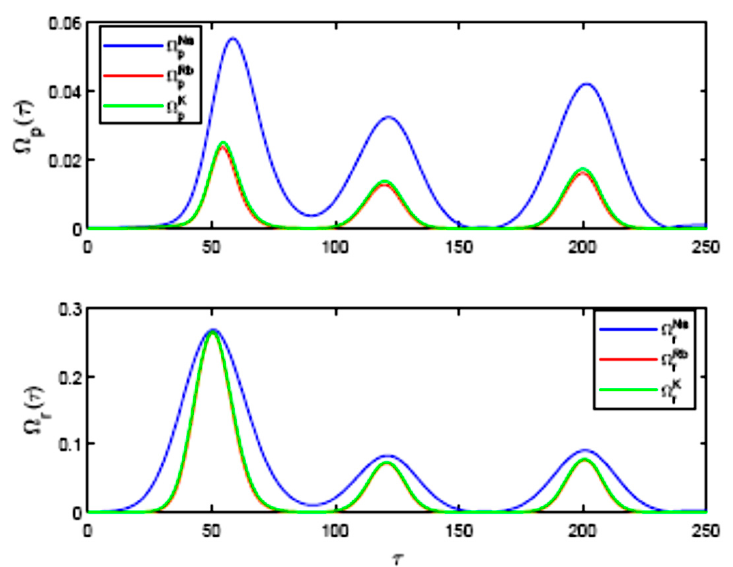
Figure 5. Pulse shaping and temporal behaviour of the field’s amplitude absolute value in probe and the drive channels.